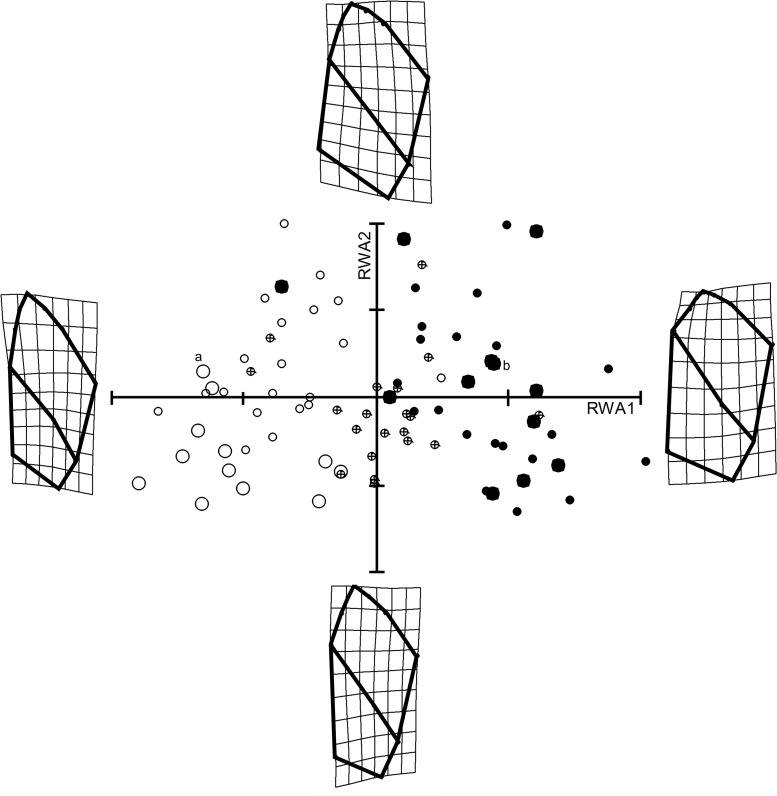
The 84 shells plotted on Relative Warp Axes 1 and 2.
Physa carolinae are shown as open circles, Physa acuta as filled circles, and hybrids as cross-circles. The parental generation is plotted as large symbols, and their F1 offspring as small symbols. Letters a and b indicate the two shells depicted in Fig. 1.